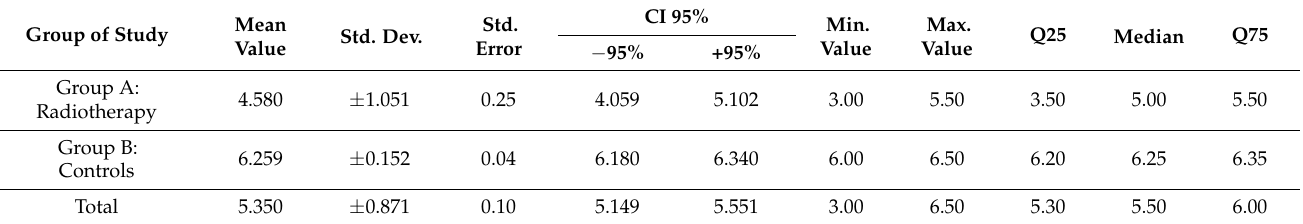
Table 3. The central tendency indicators on salivary pH.